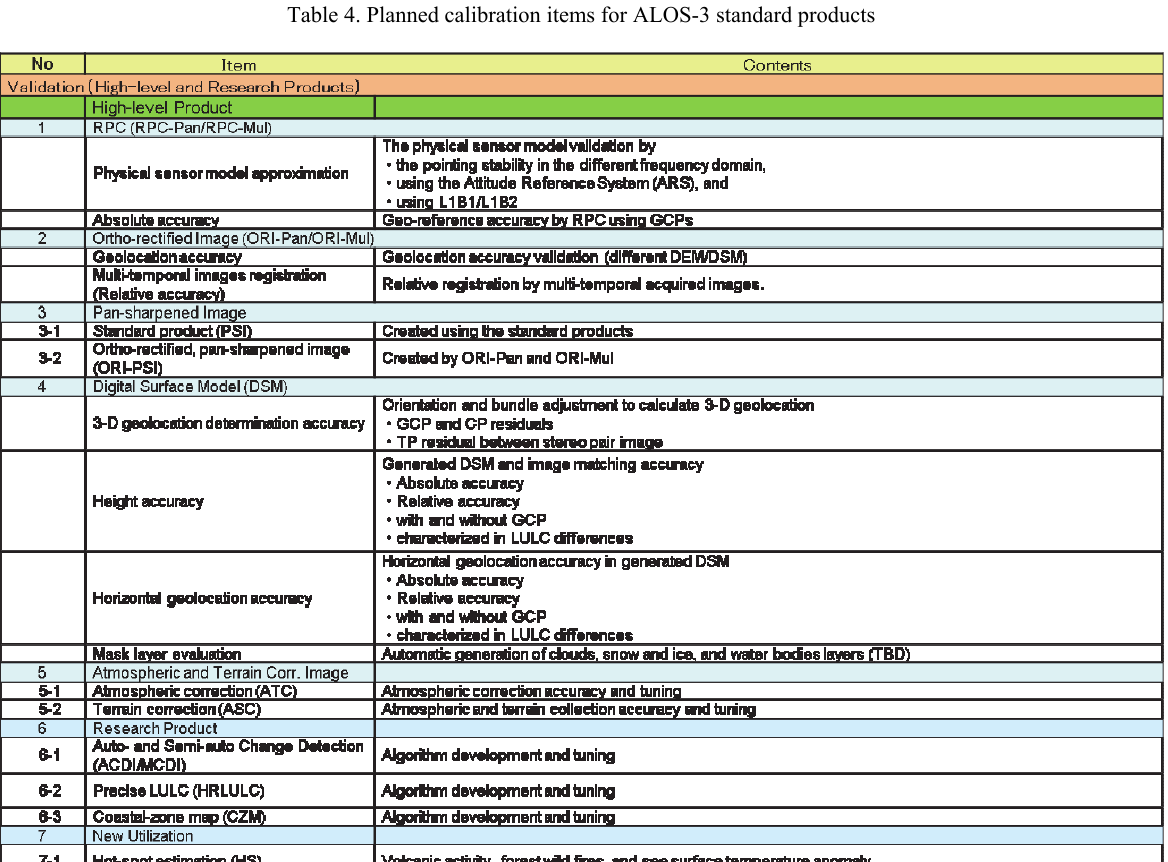
Table 5. Planned validation items for ALOS-3 high-level and research